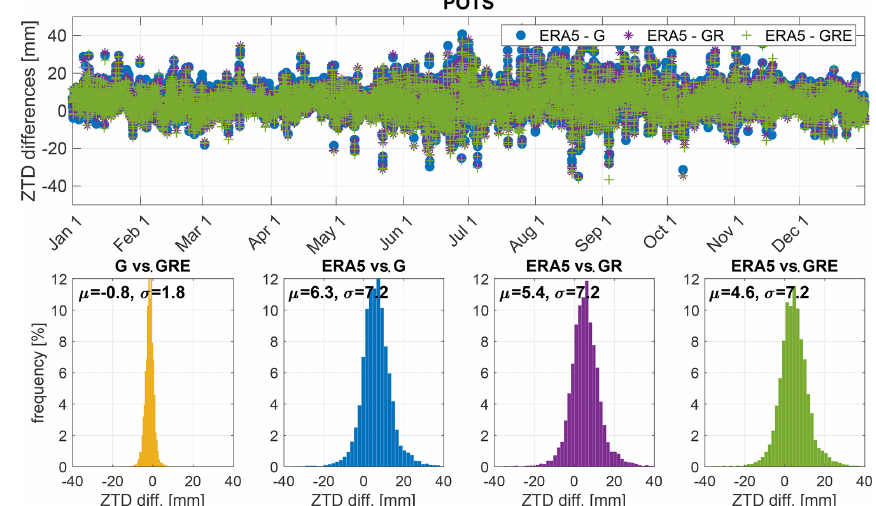
Figure 9. The ZTD difference values for station POTS (Potsdam, Germany) between the three GNSS solutions: GPS-only, GR and GRE and ERA5 model (top) and histograms of the differences between the particular solutions and models (bottom). The plots are shown for the year